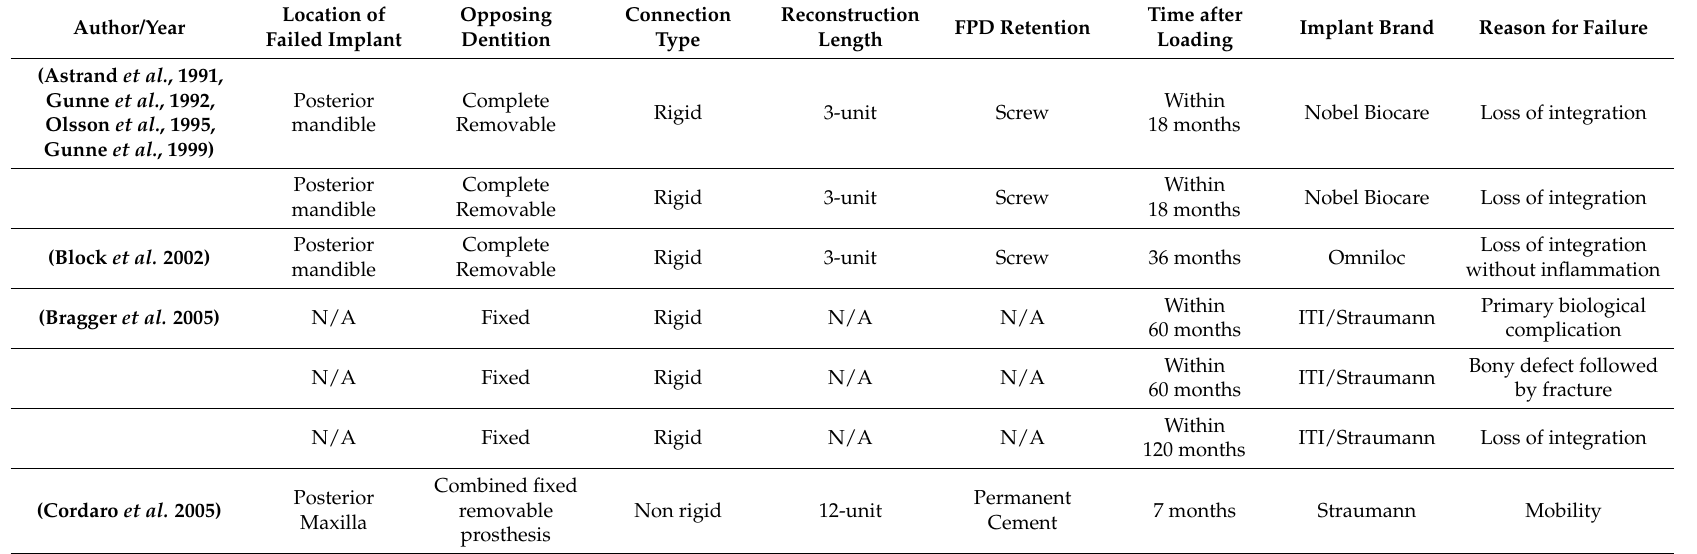
Table 4. Table of failed